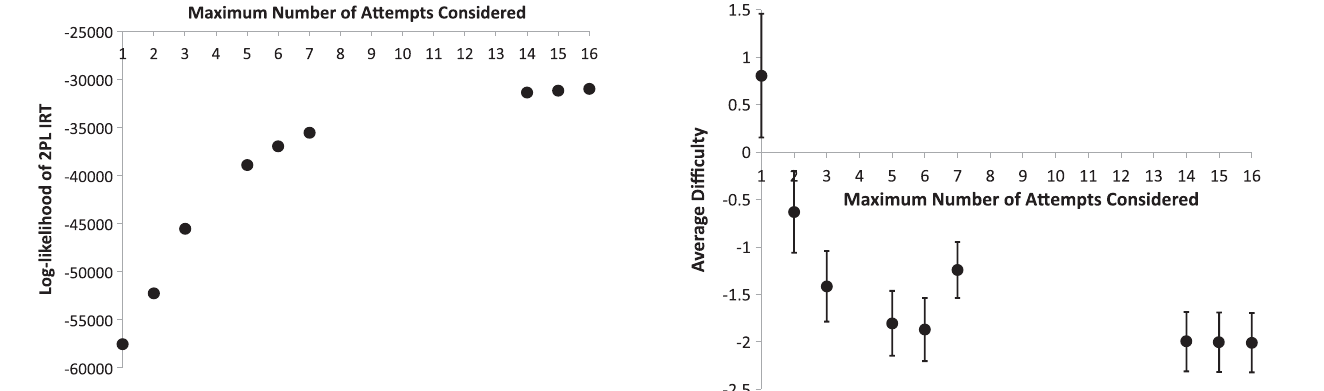
FIG. 6. Average difficulty of the homework items as a function of the maximum number N of considered attempts. Missing data points indicate that the fit did not converge. The error bars indicate the average of the standard errors on the difficulties.